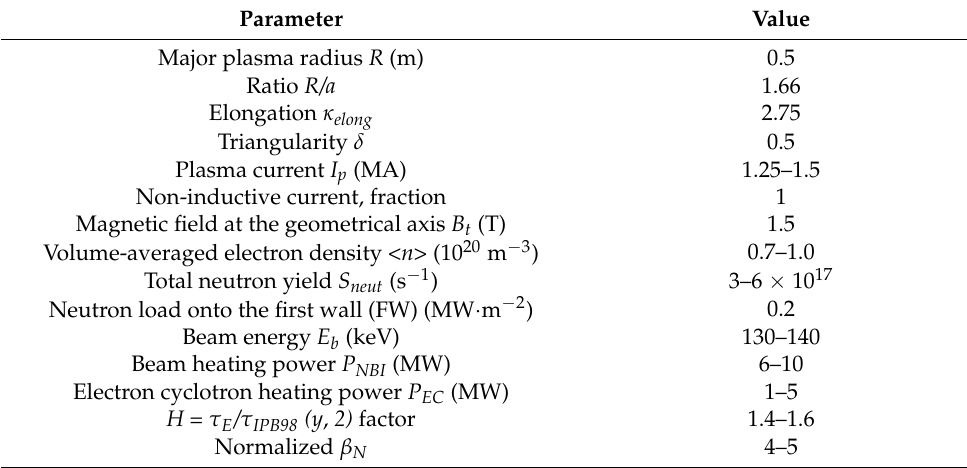
Table 1. The FNS-ST parameters used in the FC simulations.